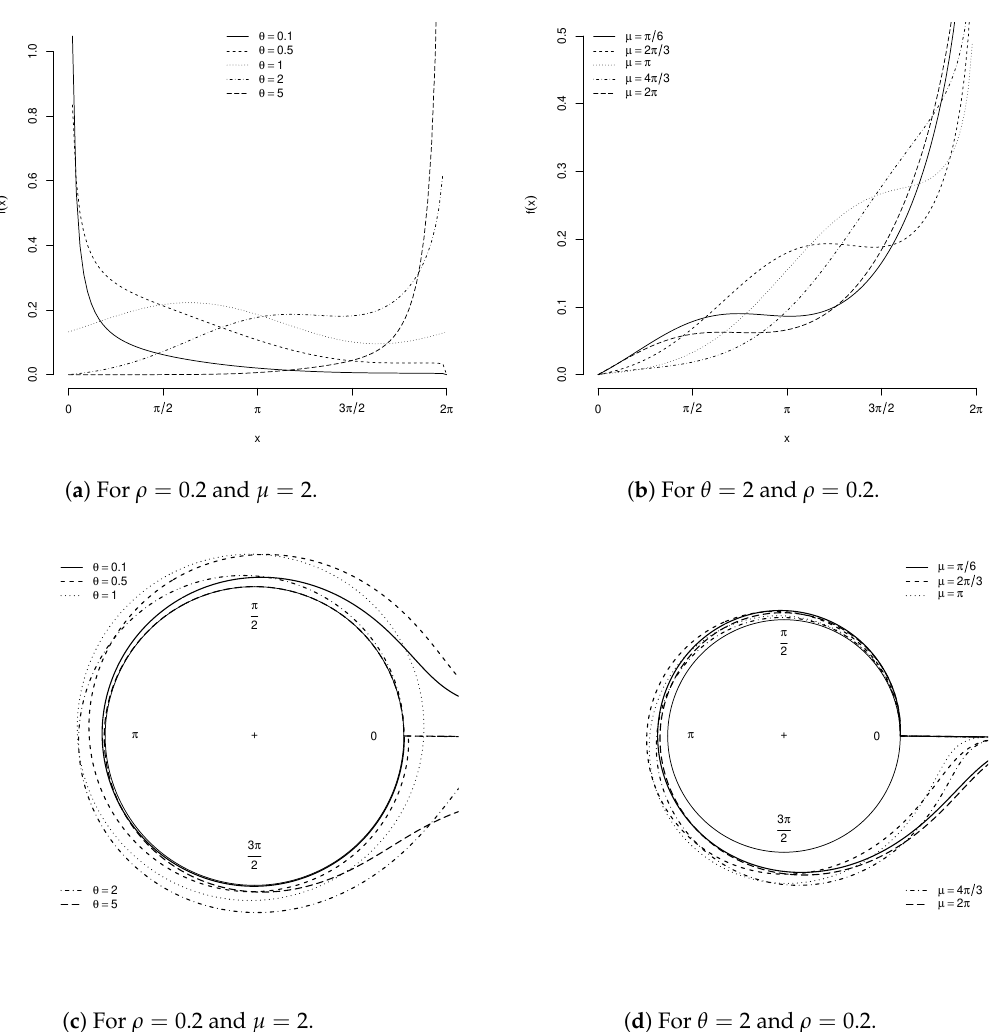
Figure 3. Cartesian and circular Γ C densities for some parametric